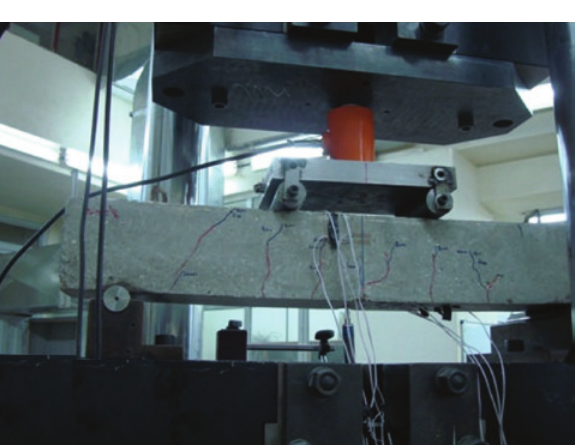
Figure 10: Experimental and FE analyses of RC specimens under fatigue loading at cycle 50,000.